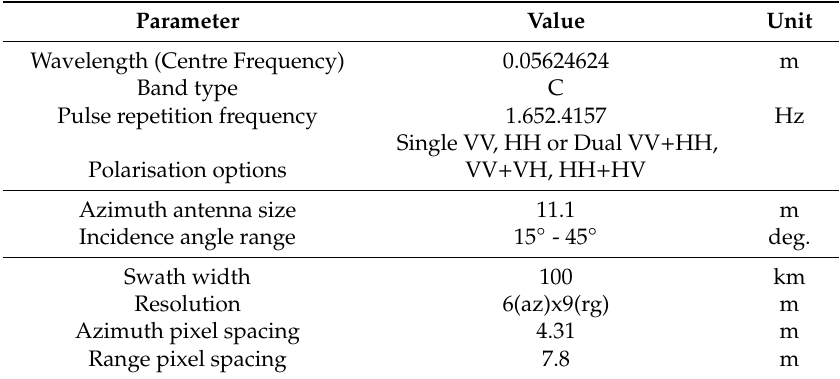
Table 1. Envisat / ASAR stripmap mode acquisition platform parameters.